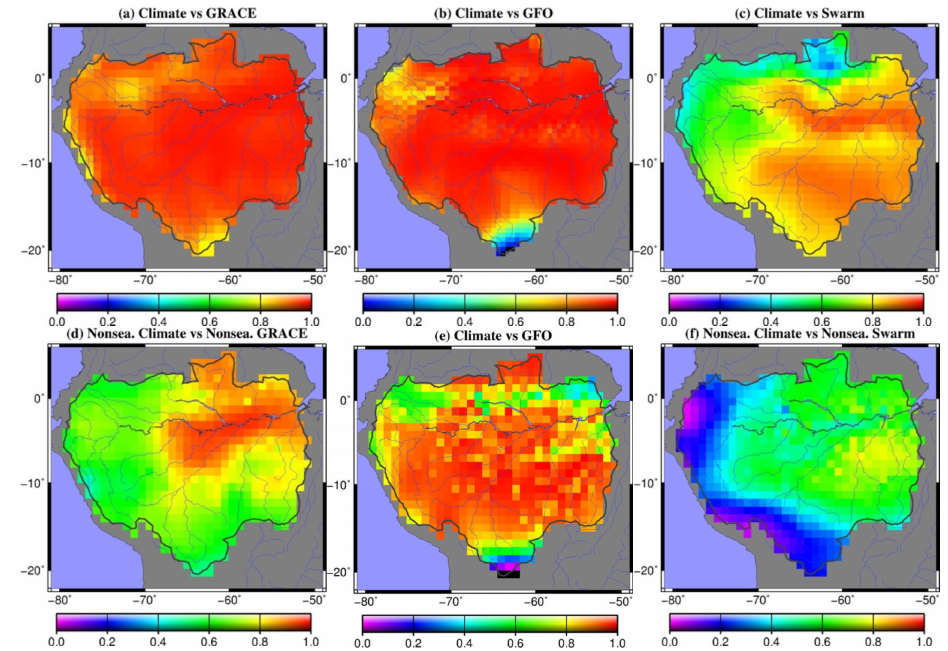
Figure 3. The correlations of the climate-driven total water storage change fields as compared to the ( a ) GRACE, ( b ) GRACE follow-on (GFO), and ( c ) Swarm TWSC at the grid scale. ( d – f ) Correlations of the related nonseasonal TWSC fields.